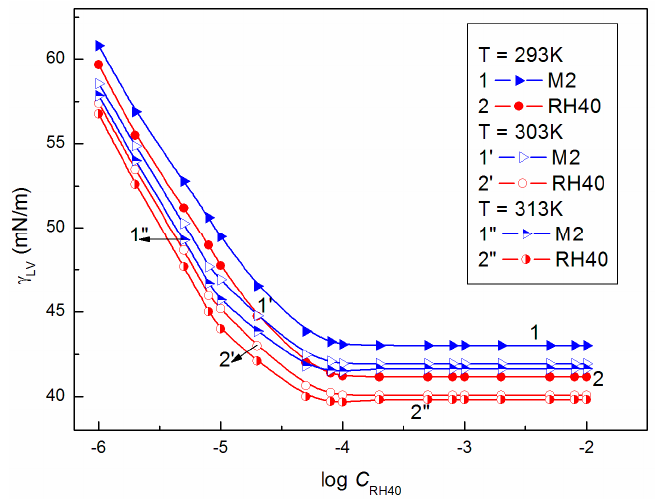
Molecules 2023 , 28 , x FOR PEER REVIEW Figure 3. A plot of the surface tension ( γ LV ) of M2 mixture aqueous solutions (curves 1, 1 (cid:48) and 1 (cid:48)(cid:48) ) Figure 3. A plot of the surface tension ( 𝛾 (cid:3013)(cid:3023) ) of M2 mixture aqueous solutions (curves 1, 1 ′ and 1 ′′ ) and RH40 aqueous solutions [22] (curves 2, 2 (cid:48) and 2 (cid:48)(cid:48) ) vs. the logarithm of RH40 concentration (log and RH40 aqueous solutions [22] (curves 2, 2 ′ and 2 ′′ ) vs. the logarithm of RH40 concentration (log C RH40 ) at a constant temperature equal to 293 K (curves 1 and 2), 303 K (curves 1 (cid:48) and 2 (cid:48) ), and 313 K 𝐶 (cid:2902)(cid:2892)(cid:2872)(cid:2868) ) at a constant temperature equal to 293 K (curves 1 and 2), 303 K (curves 1 ′ and 2 ′ ), and 313 K (curves 1 (cid:48)(cid:48) and 2 (cid:48)(cid:48) ). (curves 1 ′′ and 2 ′′ ).